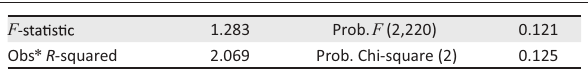
FIG URE 1: Heteroscedasticity test: Breusch–Pagan–Godfrey.